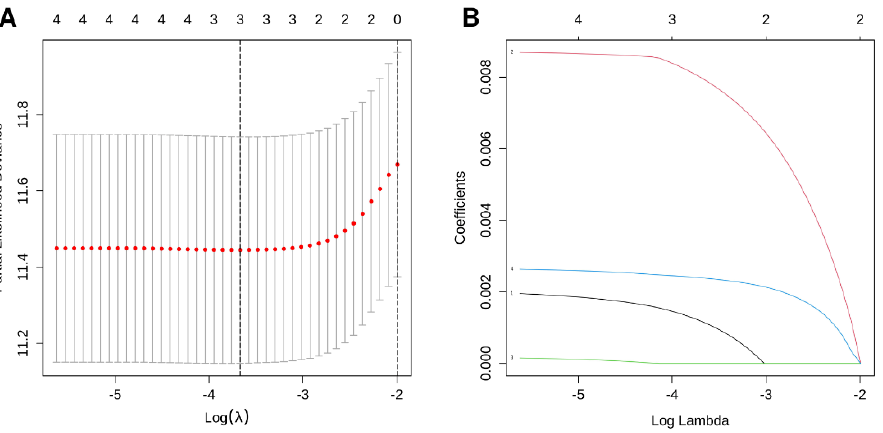
Figure 3. LASSO regression results. ( A ) LASSO coefficient profile of four overall survival (OS)-related CSIRG. ( B ) LASSO deviation profile of four OS-related CSIRG.